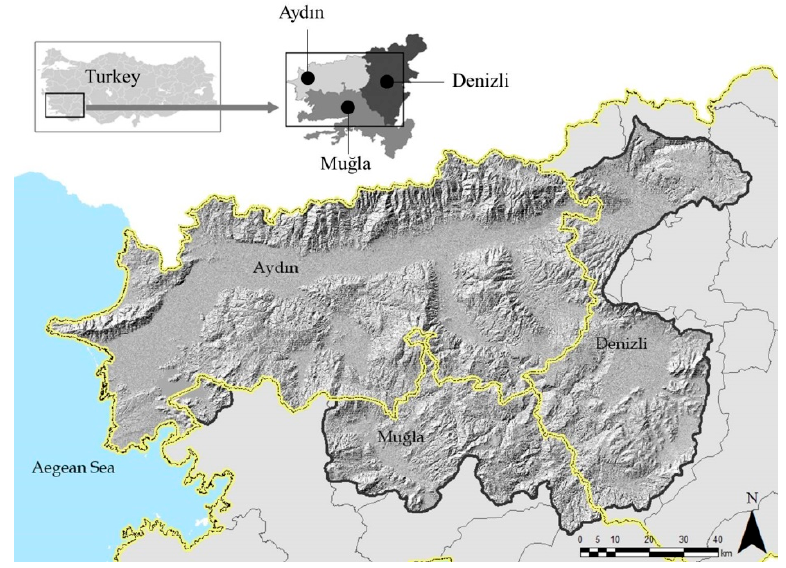
Figure 1. Geographic location and boundaries of the study area.